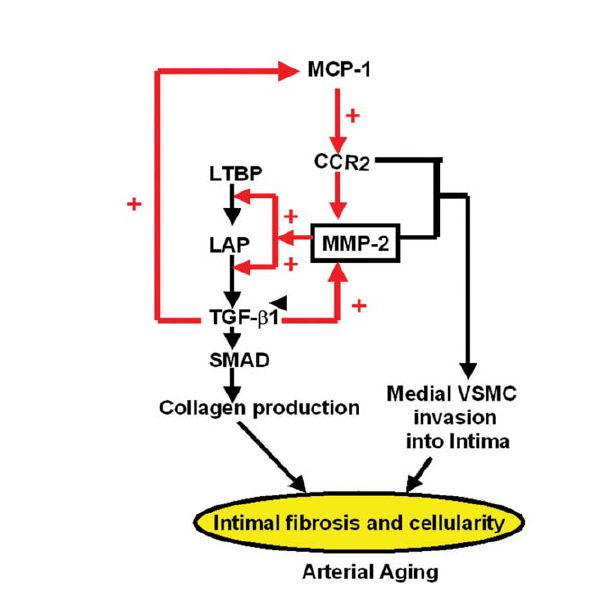
Figure 7. Simplified schematic diagram of a MCP-1/MMP-2/ TGF- b 1 loop signaling